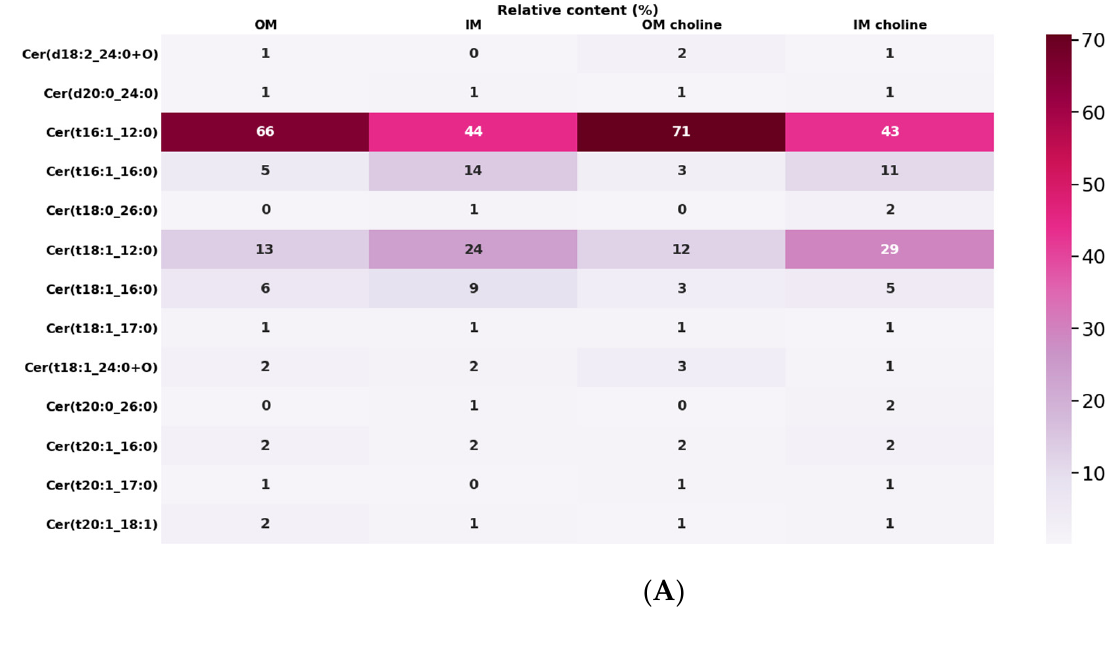
Figure 4. Profile of TG ( A ) and DG ( B ) of the OM and IM of L. gormanii grown on the medium without and with exogenous choline. Lipids were identified via LC-MS(/MS) in the positive ionization mode.